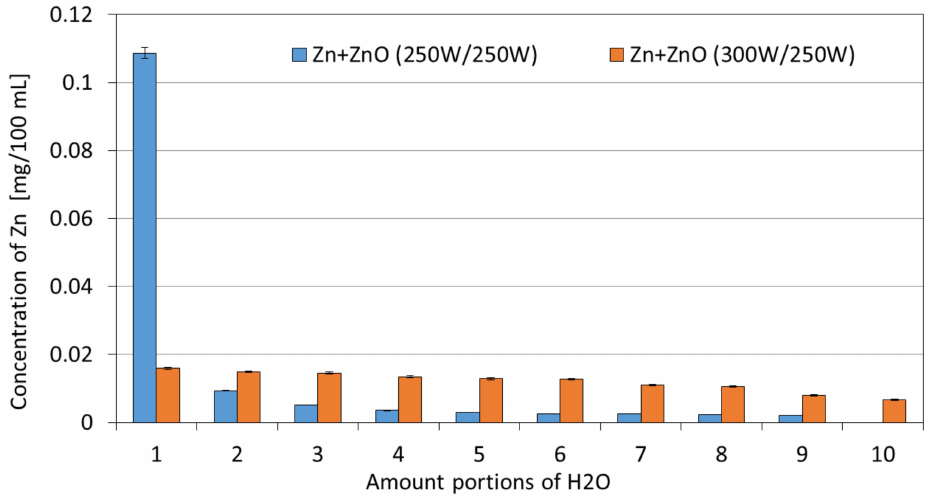
Figure 9. The Zn concentrations in filtrates obtained in the filtration processes of demineralized water through membranes with two-component